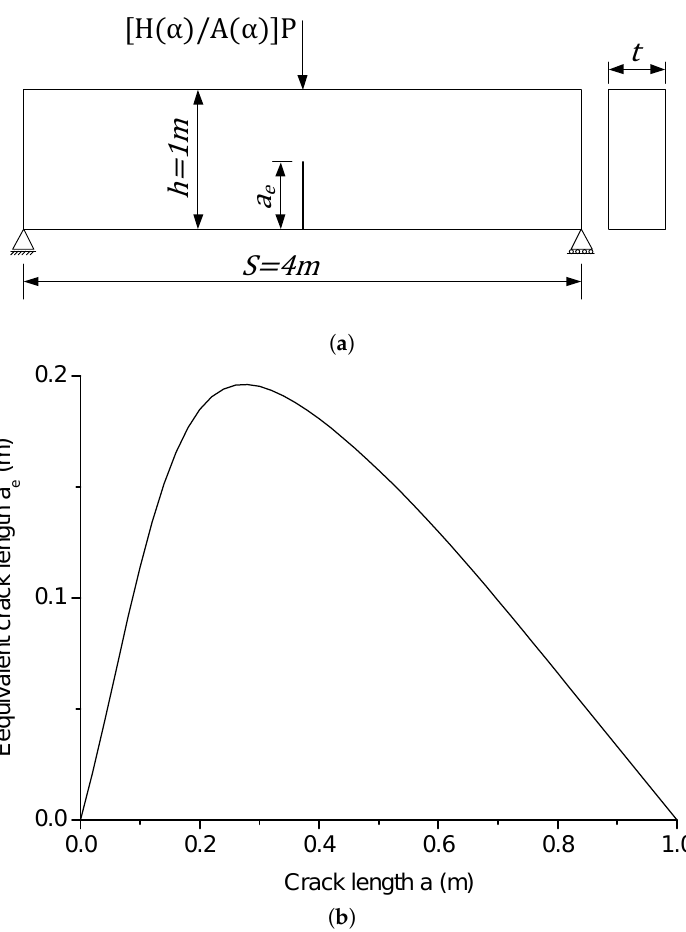
Figure 5. ( a ) Beam with equivalent loading and equivalent crack length a e and ( b ) equivalent crack length a e versus real crack length a